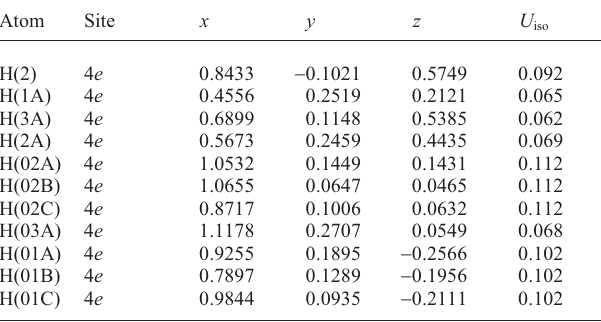
Table 2. Atomic coordinates and displacement parameters (in Å 2 )